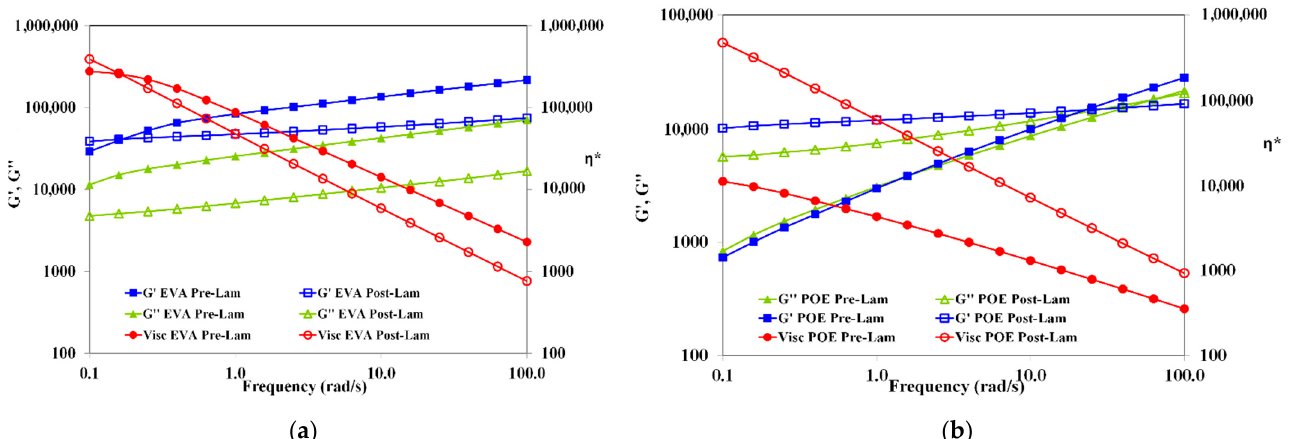
Figure 3. Storage and loss moduli (G’ and G”) and complex viscosity ( η *) of ( a ) EVApre-lam (full symbols) and EVApost-lam (open symbols) and ( b ) POEpre-lam (full symbols) and POEpost-lam (open symbols) commercial samples.